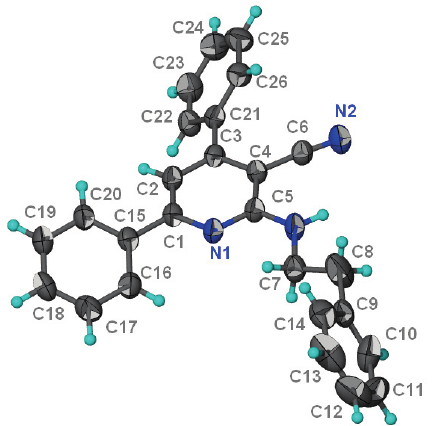
Figure 1. X-ray crystal structure of 3